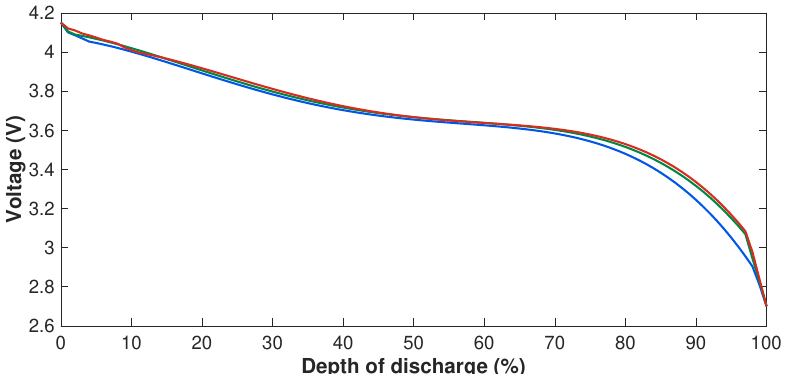
Figure 8. Experimental OCV-DoD relationship curves for second life battery at 0 °C (blue line), 25 °C (green line) and 40 °C (red line).